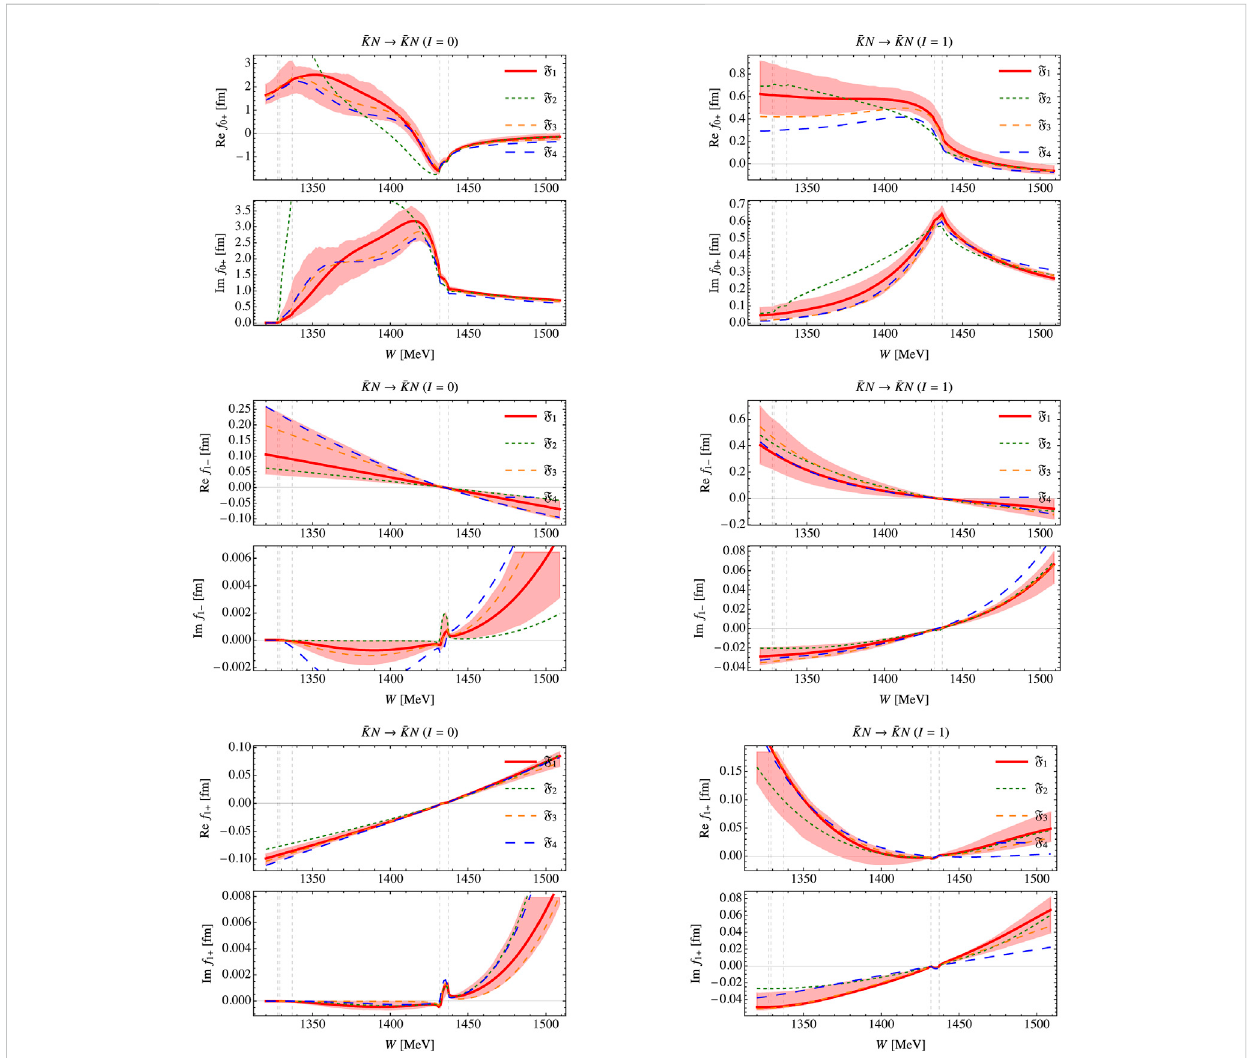
FIGURE A1 Isospin channels of the S- and P-wave amplitudes in the four fi t